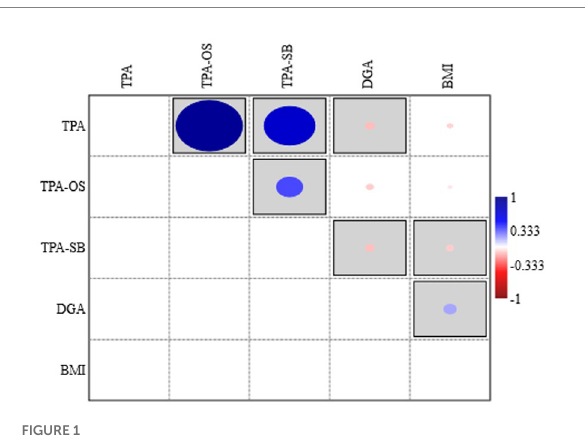
FIGURE 1 The correlation graph between TPA, TPA-OS, TPA-SB, DGA scores, and BMI. TPA, total physical activity; TPA-OS, total physical activity out of school; TPA-SB, total physical activity-school based; DGA, digital game addiction; the correlation coefficients shown in the gray box represent statistical significance ( p < 0.05); the size of the circle in the gray box indicates the level of correlation; blue color indicates positive and red color negative